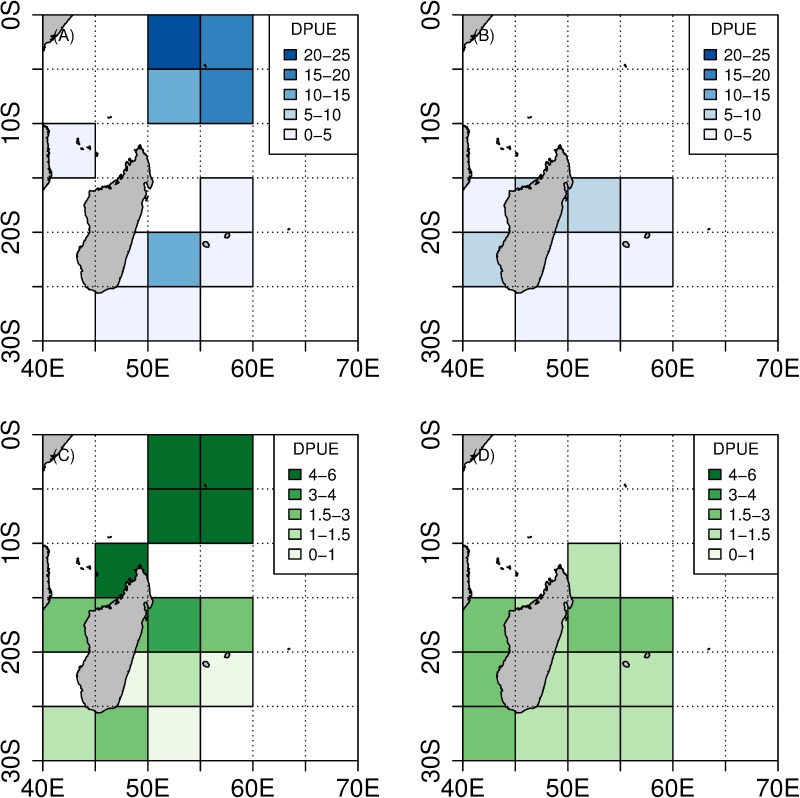
Distribution of DPUE* (in number of depredated fish per 1000 hooks).DPUETW* is depicted in blue, DPUESH* is depicted in green. (A) Distribution of DPUETW* between 2004 and 2010. (B) Distribution of DPUETW* between 2011 and 2015. (C) Distribution of DPUESH* between 2004 and 2010. (D) Distribution of DPUESH* between 2011 and 2015.